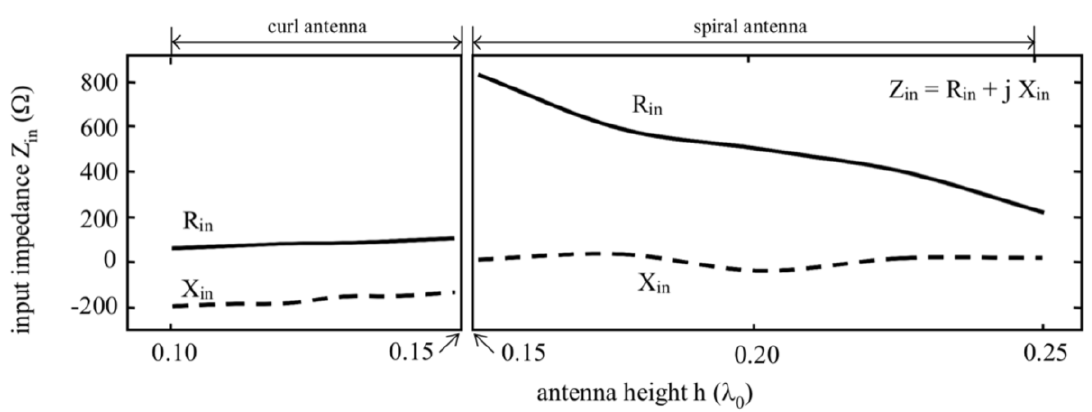
Figure 4. Input impedance versus antenna height h .